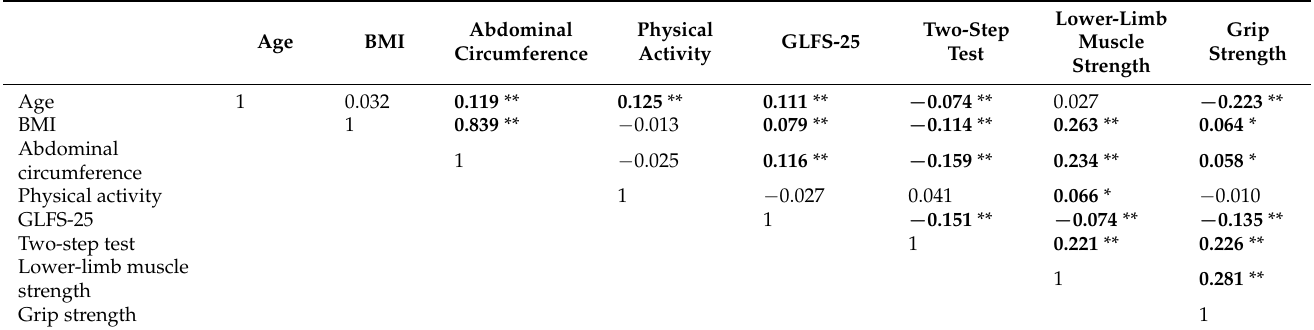
Table 2. Correlations between age and the various measurements using Spearman’s correlation